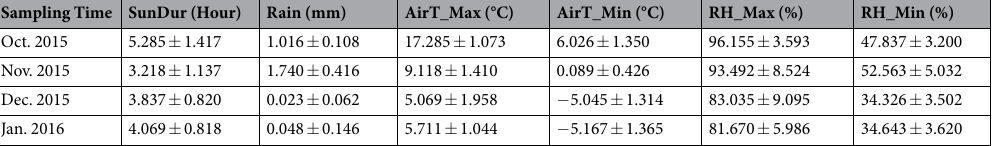
Table 1. Fundamental meteorological data from October 2015 to January 2016. SunDur, accumulated duration of sunshine; Rain, average rainfall; AirT_Max, maximum air temperature; AirT_Min, minimum air temperature; RH_Max, maximum relative humidity; RH_Min, minimum relative humidity.